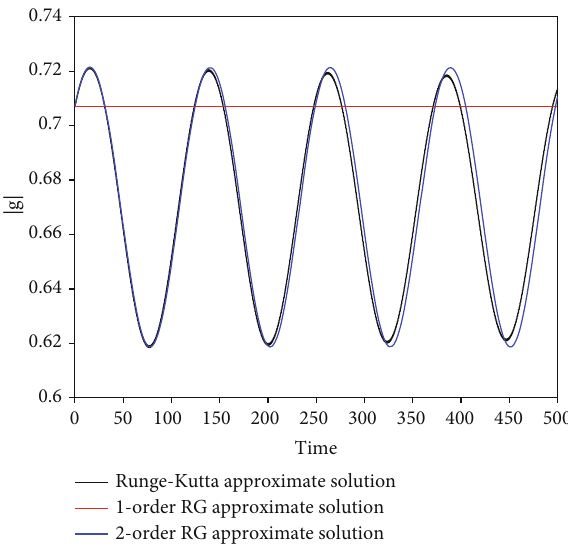
Figure 5: RG vs. Runge-Kutta approximate solutions of two-level systems in high-order weak driving = 5 , λ = 1 , v = 1 + i , ε = 0 : 05 , and δ = 1 . The simulations of g Figure 5 illustrate that the fi rst-order approximate solution is not reliable in two-level systems with the high-order weak driving control. But the second-order approximate solution is a more accurate one.